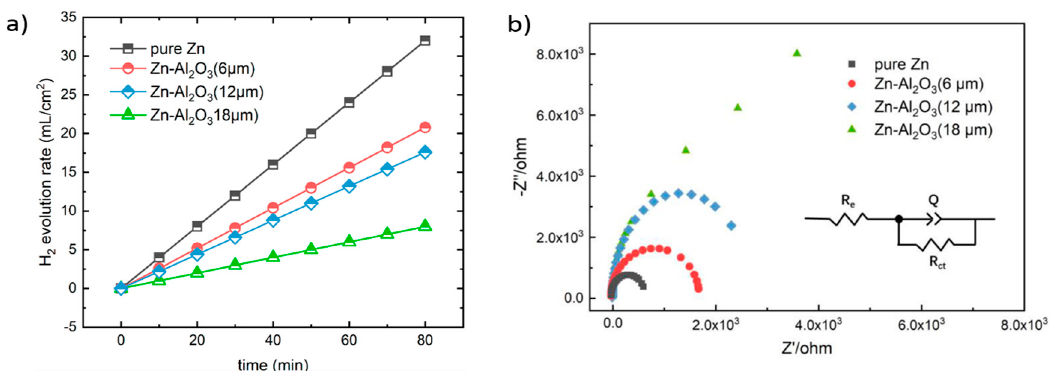
Figure 6. ( a ) Hydrogen evolution rates of bare and Al 2 O 3 -coated zinc substrates with various coating thicknesses in 4 M KOH solution; ( b ) Nyquist plots obtained by Electrochemical Impedance Spectroscopy (EIS) for bare and Al 2 O 3 -coated zinc substrates in 4 M KOH solution. Inset corresponds to the equivalent circuit model for fitting the impedance data. Reprinted with permission of [51].